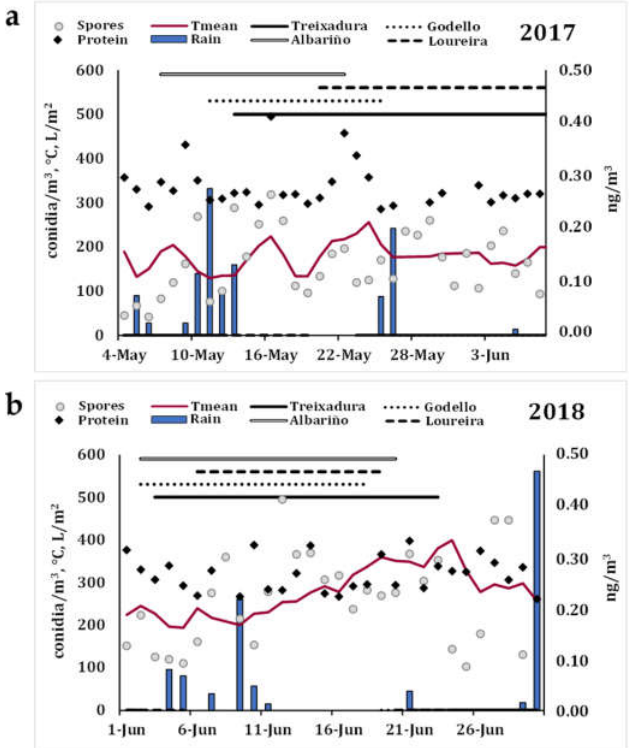
Figure 4. Airborne B. cinerea conidia concentrations (Spores, spores/m 3 ), airborne B. cinerea protein concentrations (Protein, ng/m 3 ), and the meteorological conditions of mean temperature in °C (Tmean) and rainfall in L/m 2 (Rain) during the study period in 2017 ( a ) and 2018 ( b ), considering the flowering stage of the grapevine varieties ‘Treixadura’, ‘Godello’, ‘Albariño’ and ‘Loureira’. ( a ): Spores × 1.5, Tmean × 10, Rain × 10 (Tables S1and S2). ( b ): Tmean × 15, Rain × 15 (Tables S3 and S4).